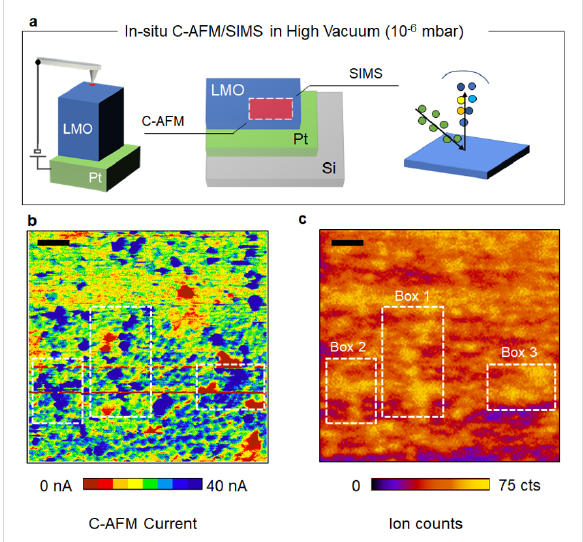
Figure 2: Combined C-AFM and SIMS analysis of a RF-sputtered LMO film. (a) Schematic of the measurement setup. The system is in high vacuum (10 − 6 mbar). (b) Local current map as probed by C-AFM (sample bias − 8 V) and corresponding (c) local chemical profile of lithi- um as measured by SIMS on the same area (scale bar 2 µm). Both C-AFM and SIMS indicate the segregation of the film in phases